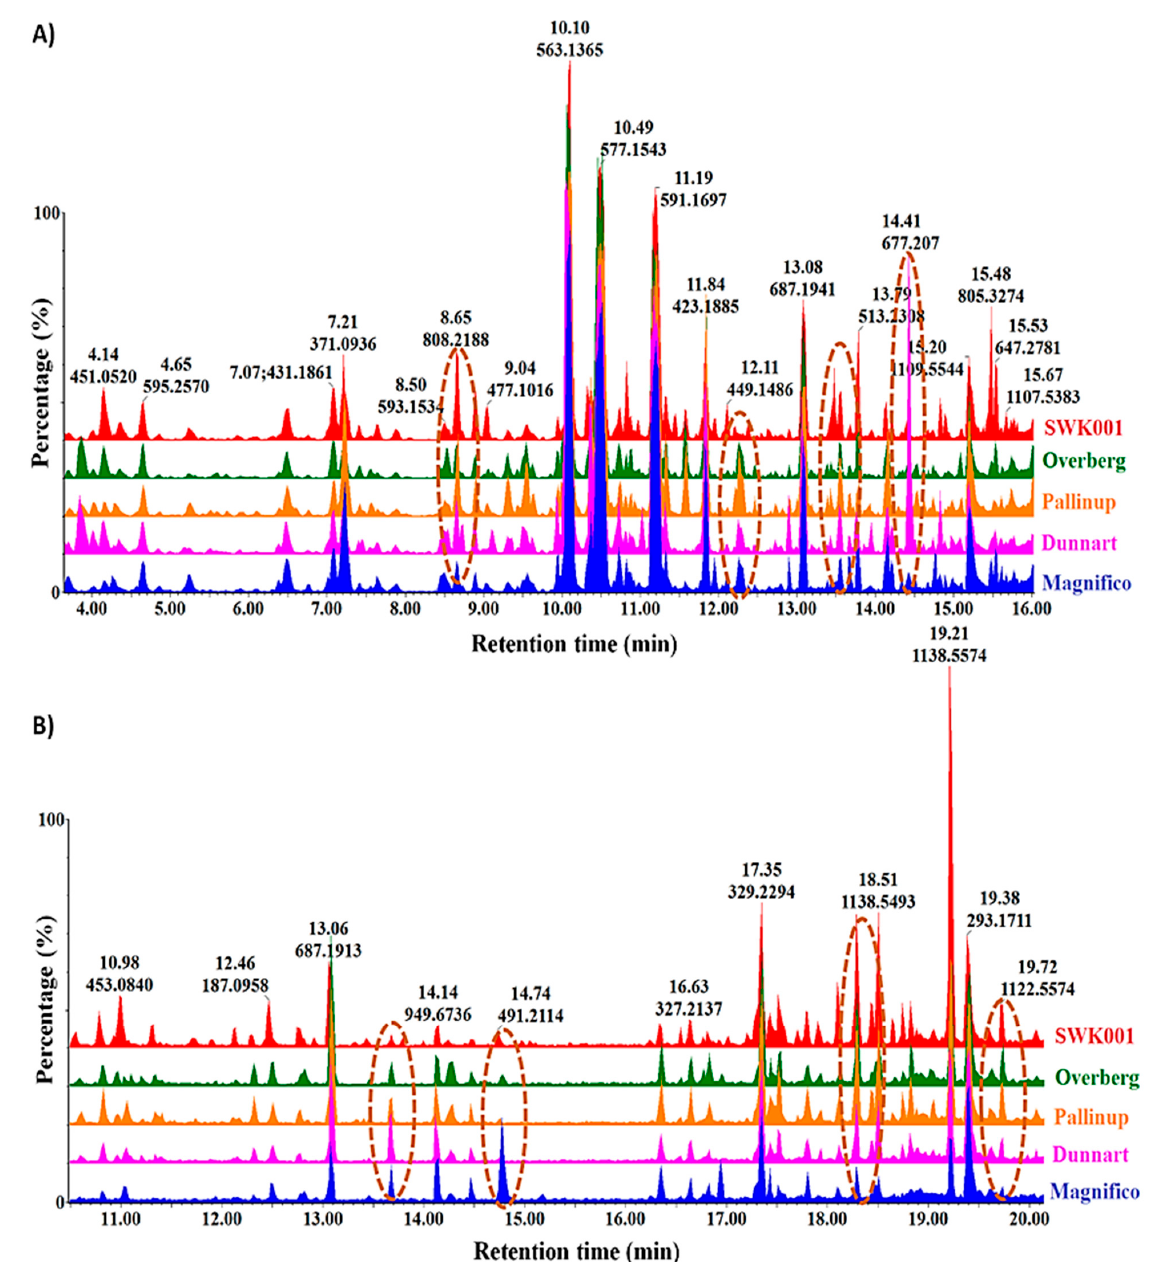
Figure 2. Ultra-high performance liquid chromatography (UHPLC) coupled to mass spectrometric (MS) detection. The figure compares base peak intensity (BPI) MS chromatograms of methanol ( A ) leaf and ( B ) root extracts from five oat cultivars (SWK001, Overberg, Pallinup, Dunnart and Magnifico) at the seedling stage. These represent the chromatographic separation based on the polarity of the different compounds in negative ionisation mode (ESI–), separated on an HSS T3 reverse-phase column. The dashed oval structures point out some cultivar-exclusive variations that illustrate differences in the phytochemical profiles of the cultivars.